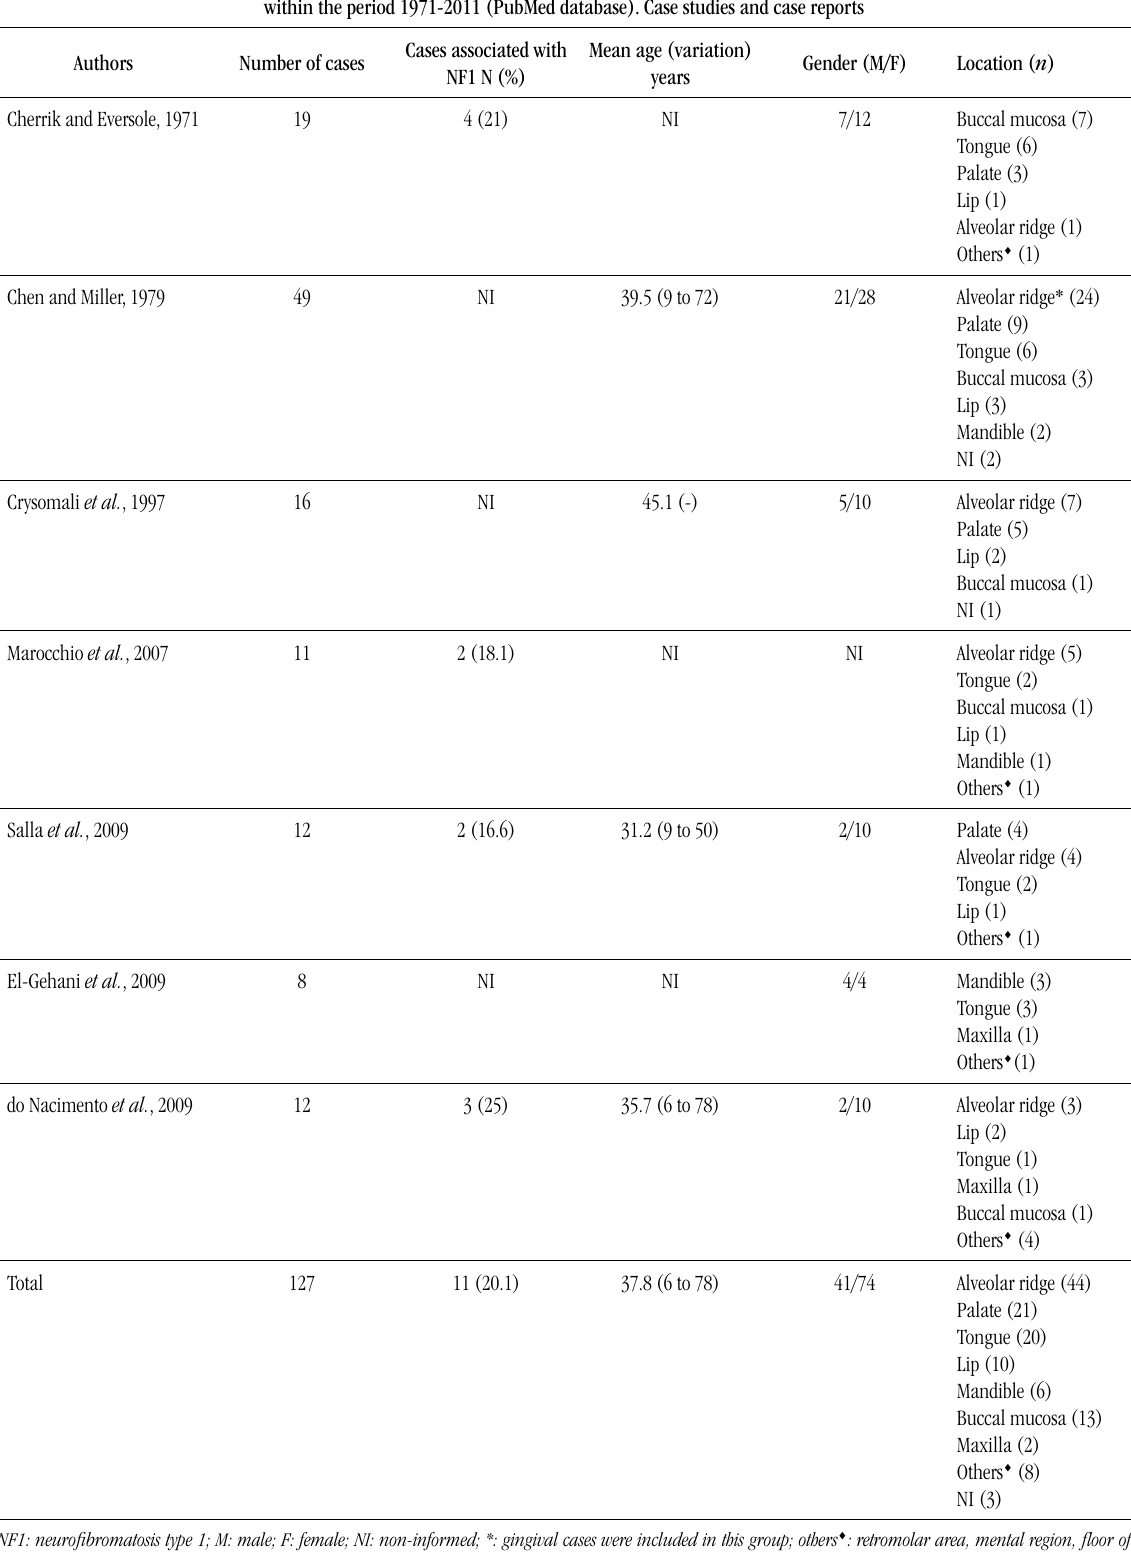
tABLE 3 – Clinicopathological data of 127 intraoral neurofibromas reported in the literature within the period 1971-2011 (PubMed database). Case studies and case